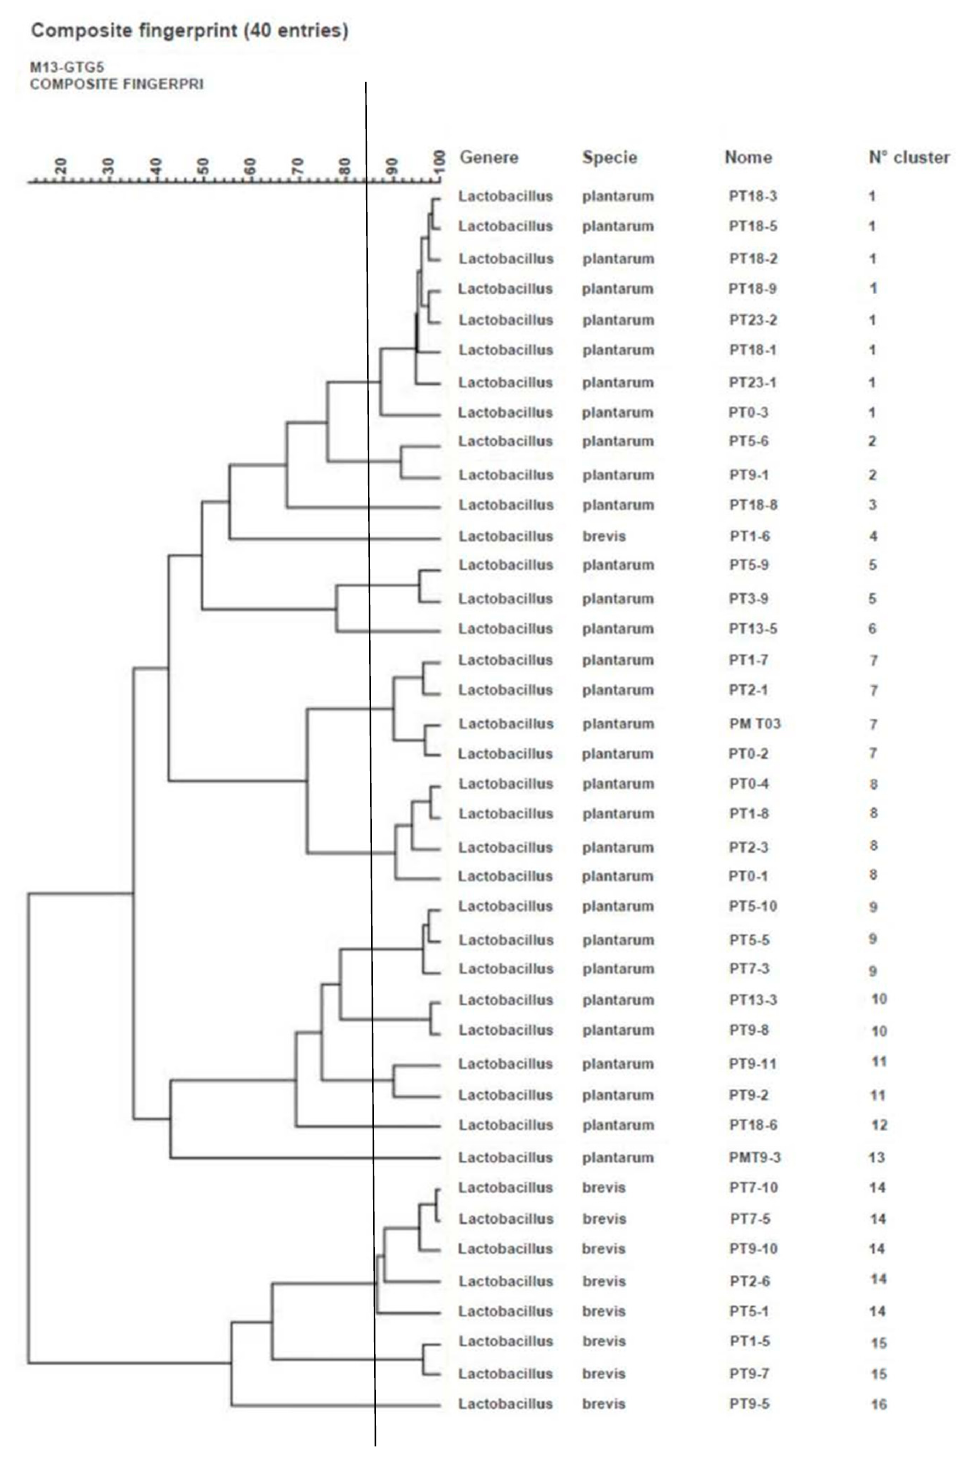
Figure 1. Dendrogram showing relationships among the 40 Lactobacillus spp. isolated from sheep sausage based on RAPD-PCR and rep-PCR banding profiles.